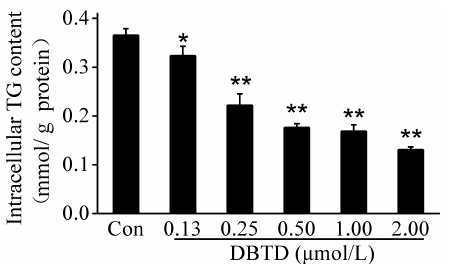
Molecules 2017 , 22 , x FOR PEER REVIEW Figure 3. Triglyceride (TG) contents in HL7702 cells treated with different concentrations of DBTD (0, 0.13, 0.25, 0.50, 1.00, and 2.00 μmol/L) for 24 h. The TG concentrations were normalized to the corresponding total cell protein contents. Values are expressed as the mean ± SD ( n = 3), * p < 0.05, ** p < 0.01 versus control. Con = control.